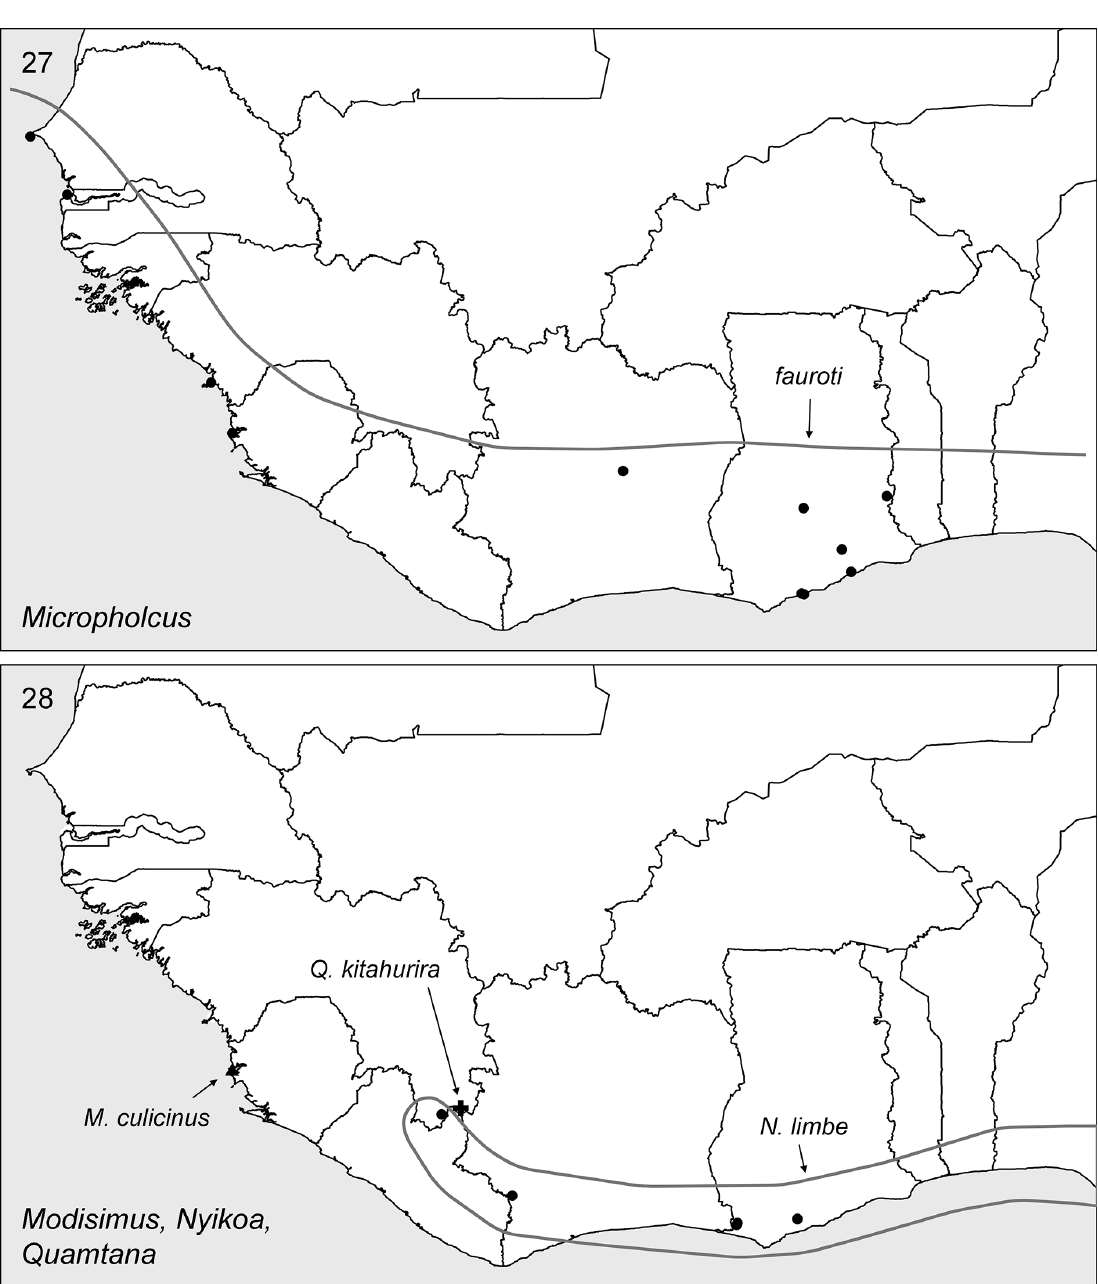
Figs 27-28. Known distributions of the genera Micropholcus Deeleman-Reinhold & Prinsen, 1987, Modisimus Simon, 1893, Nyikoa Huber, 2007, and Quamtana Huber, 2003 in West